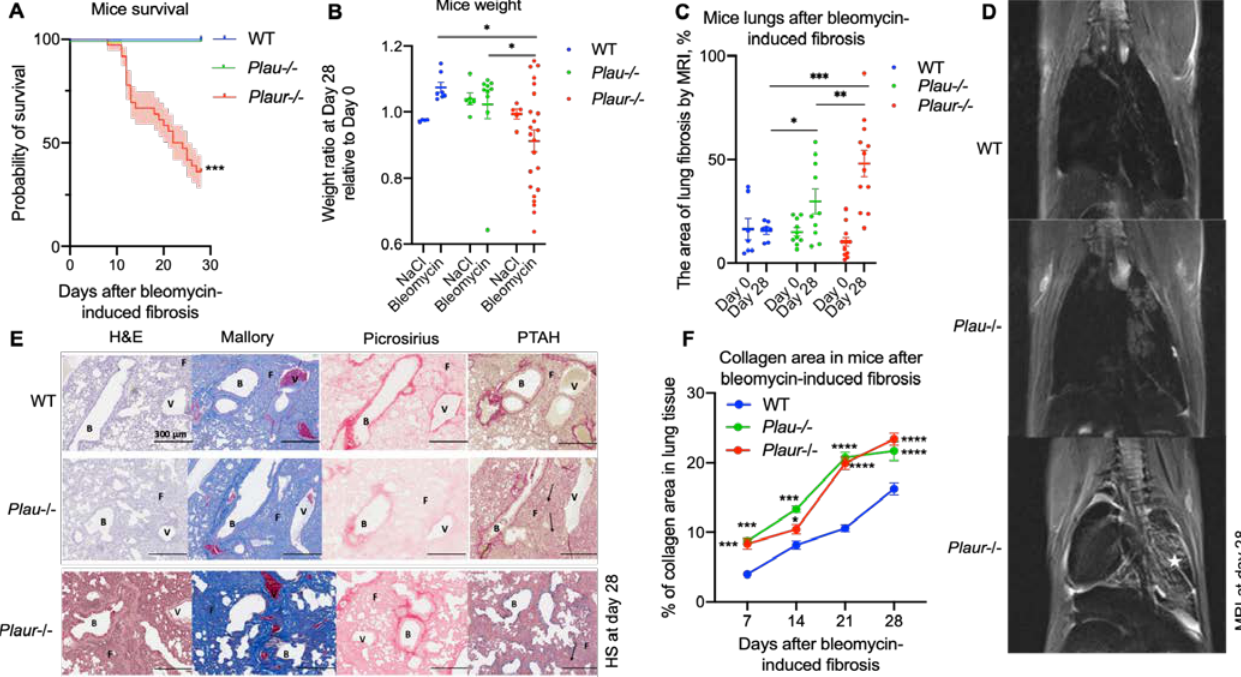
Figure 5. Differential progress of pulmonary fibrosis between wild-type (WT) and Plau -deficient ( Plau -/-) or Plaur -deficient ( Plaur -/-) mice after instillation with bleomycin. Bleomycin (3 mg/kg) was administered into WT, Plau -/- and Plaur -/- mice by intratracheal instillation at day 0. Instillation of NaCl solution was used as a control. ( A ) Kaplan–Meier survival curves, % ± SE, for WT, Plau -/- and Plaur -/- mice following intratracheal instillation of bleomycin. *** p < 0.001, log-rank test. ( B ) Mice were weighed before bleomycin or NaCl administration (day 0) and 28 days after. Body weight at day 28 divided by body weight day 0 (weight ratio) individual values, mean ± SEM are presented. * p < 0.05, 2-way ANOVA, Holm–Š í d á k’s test. ( C ) The % of lung tissue with fibrosis at day 0 and day 28 of bleomycin intratracheal instillation in WT, Plau -/- and Plaur -/- mice. * p < 0.05, ** p < 0.01, *** p < 0.001, 2-way ANOVA, Holm–Š í d á k’s test. ( D ) Typical MRI images obtained 28 days after bleomycin administration to WT, Plau -/- and Plaur -/- mice, the affected lung areas on the MRI images appear light, and the intact lungs appear dark. Asterisk indicates the area of severe lung damage. ( E ) Representative micrographs of 5- µ m paraffin lung tissue sections stained with hematoxylin and eosin (H&E), Mallory stain (detection of total collagen), picrosirius red stain (selective detection of type I and III collagen) and phosphotungstic acid-hematoxylin stain (PTAH, detection of fibrin). Histological sections (HS) of lung tissues of WT, Plau -/- and Plaur -/- mice 28 days after bleomycin administration are presented. B, bronchus or bronchiole; F, fibrosis; V, vessel. The arrow points to collagen fibers in the pulmonary interstitium in the area of fibrosis. Scale bar—300 µ m. ( F ) The analysis of collagen deposition in WT, Plau -/- and Plaur -/- mice 7, 14, 21 and 28 days after bleomycin administration by picrosirius red stain. The mean % of tissue area ± SEM with collagen deposition is presented. * p < 0.05, *** p < 0.001, **** p < 0.0001, 2-way ANOVA, Holm–Š í d á k’s